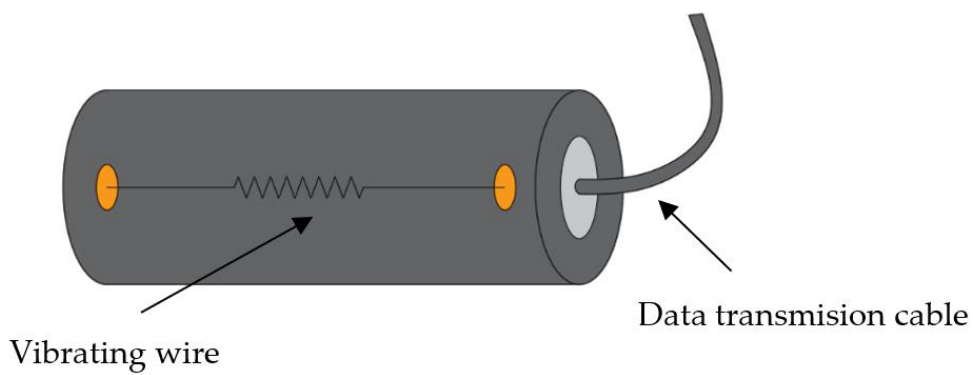
Figure 7. Scheme of the vibrating wire strain gauge [44].